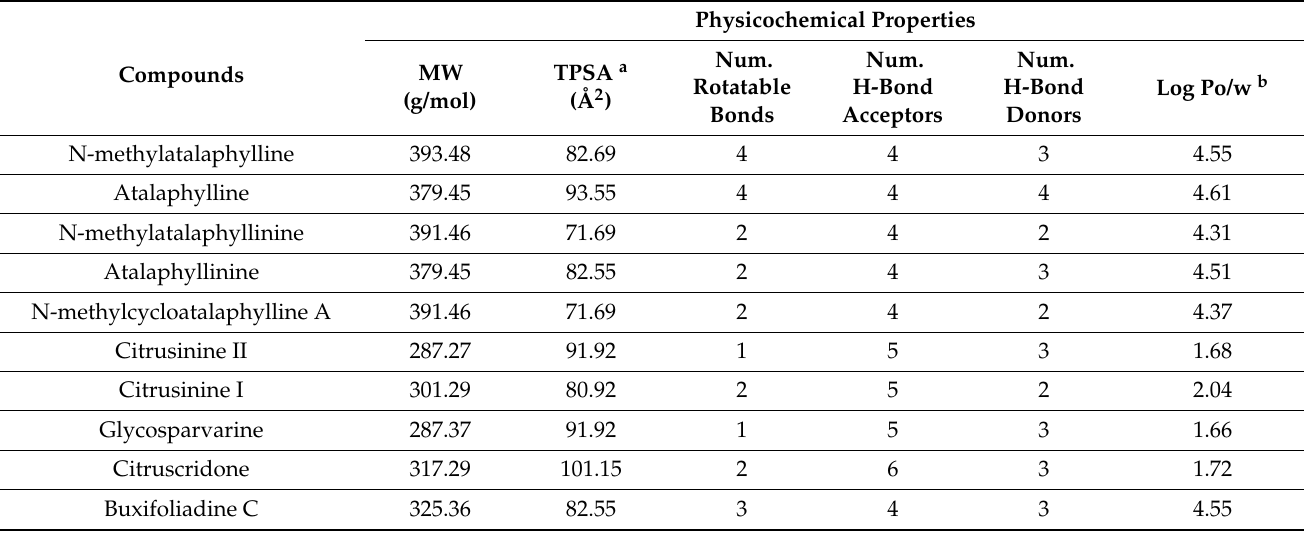
Table 1. Physicochemical properties of acridones predicted by in silico analysis (SwissADME program).